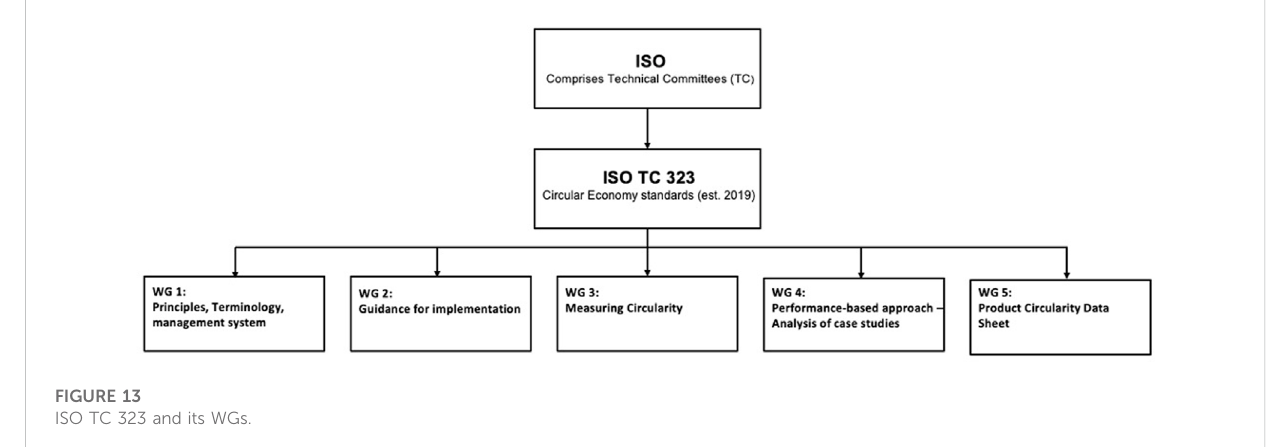
ISO TC 323 and its